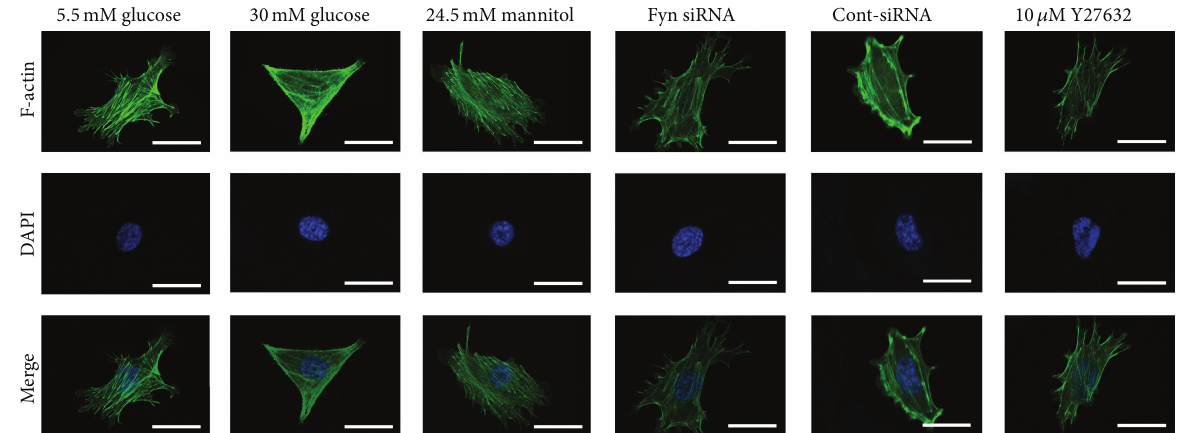
Figure 1: Reorganization of the F-actin cytoskeleton in podocytes by confocal microscopy. Podocytes under 5.5 mM glucose conditions (column 1) demonstrated that F-actin is distributed as obvious homogenous bundles that traverse the cell along the axis of the podocyte. 30 mM glucose stimulation for 48 hours (column 2) showed an assembly of F-actin in cortical regions, agminated F-actin along the cell periphery, and a slightly diffuse cytoplasmic distribution. Podocytes transfected with Fyn siRNA and then stimulated by 30mM glucose for 48 hours (column 4) showed reversed F-actin distribution. Pretreatment with 10 𝜇 M Y27632 for 30 minutes revealed similar F-actin amelioration (column 6). Podocytes that were exposed to high osmotic pressure (column 3) or transfected with Cont-siRNA (column 6) were considered as